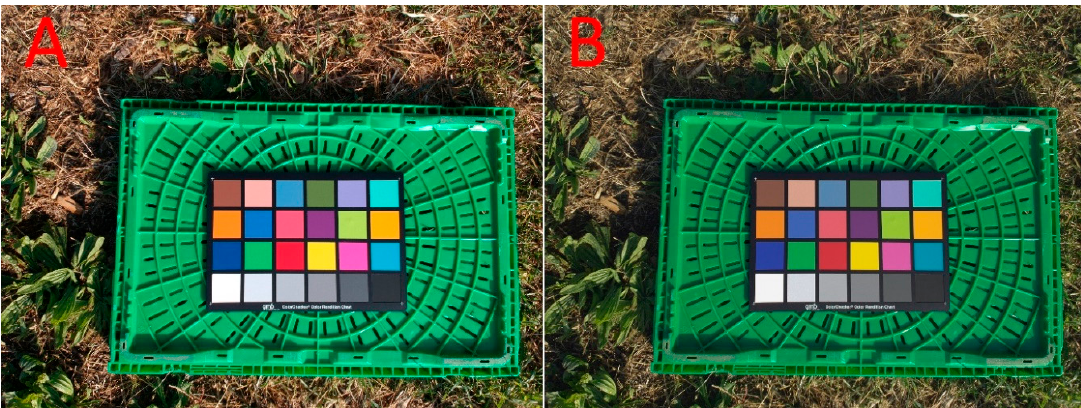
Figure 2. ( A ) Original acquired image from light drone DJI ™ SPARK ™ with the color checker